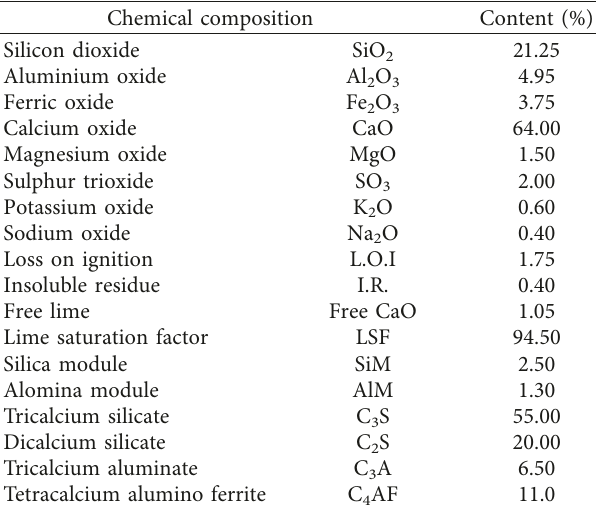
Table 2: XRF analysis of used